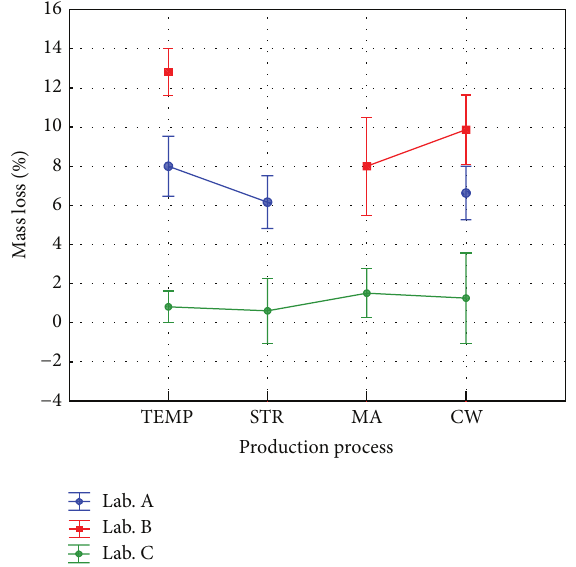
Figure 7: ANOVA for the independent parameters Institute and production type on mass loss.